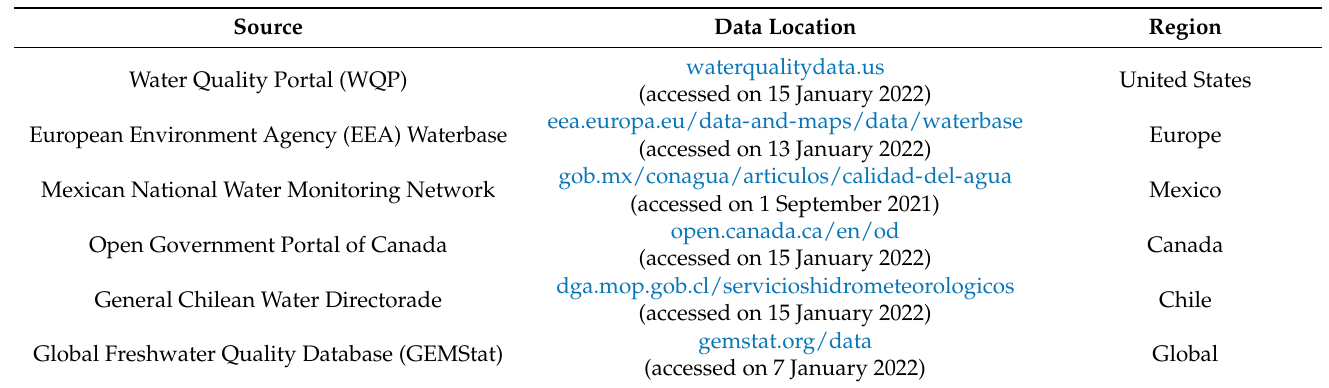
Table 1. Source of national and international water quality datasets acquired in this study.